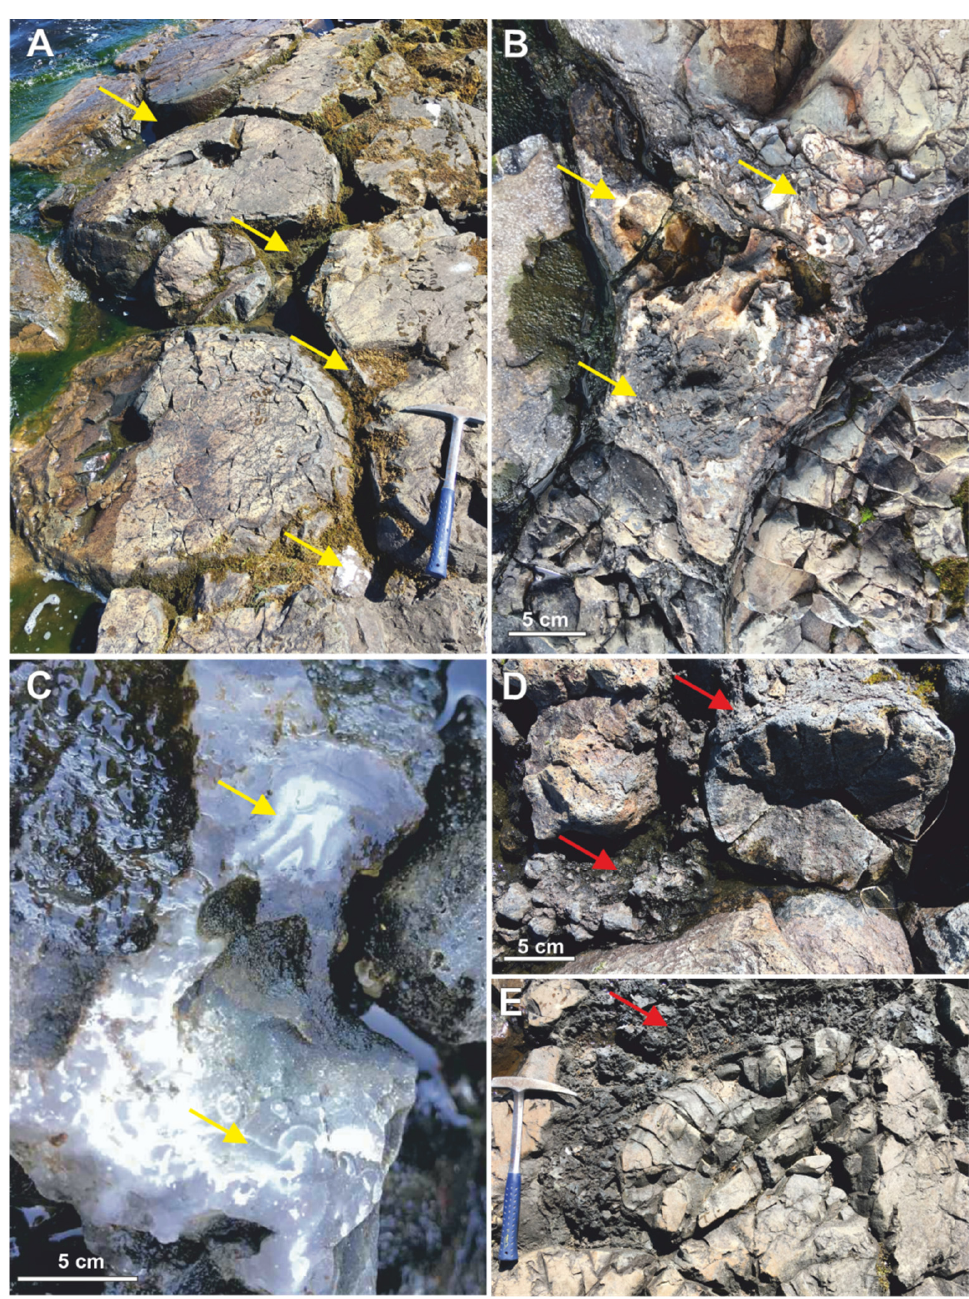
Figure 2. Field outcrop photographs illustrating black agates’ location in the Paleoproterozoic volcanics within Onega Basin LSH (ZF). ( A ) Agates in gas vesicles and inter-pillow lava space (Glubokii Navolok), ( B ) agates in the inter-pillow lava space (Glubokii Navolok), ( C ) banded agates in the inter-pillow lava space (covered by water) (Glubokii Navolok), and ( D , E ) interbeds of carbon-rich rock (“shungite”) in the inter-pillow lava space (Solomennoe). Yellow arrows point to the black agates, and red arrows to carbon-rich